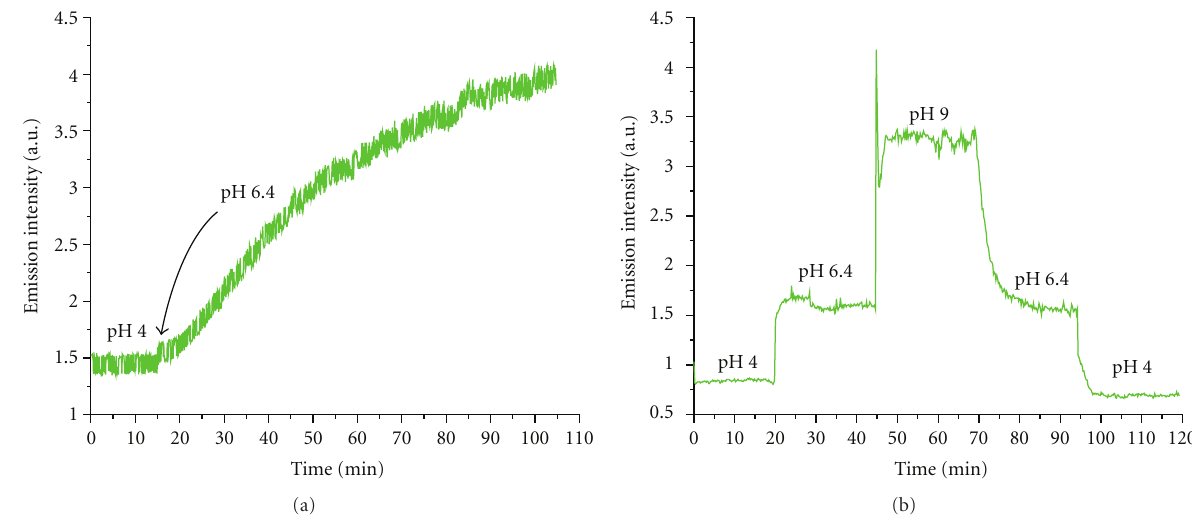
Figure 4: Fluorescence curves of the (a) non-templated and (b) templated sensor junctions showing a tenfold improvement of the response time. Each datapoint represents the average of twenty laser excitation